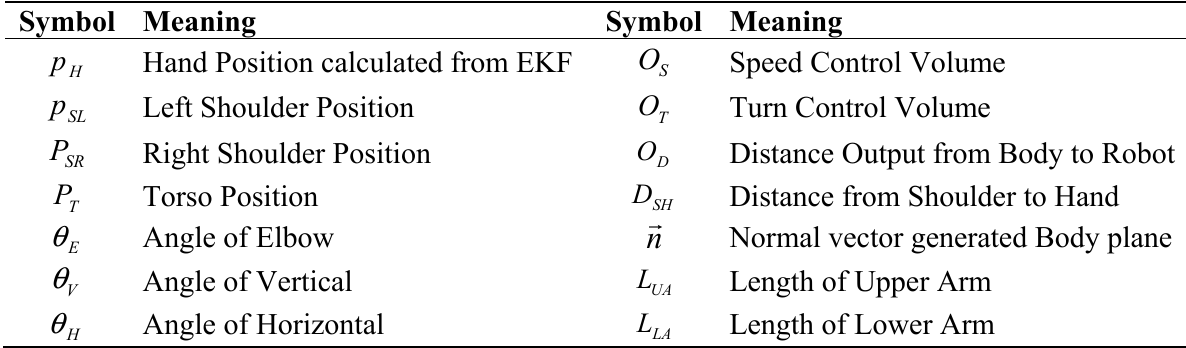
Table 3 lists the related symbols for generating intelligent lead output. Table 3. Symbols for intelligent lead output